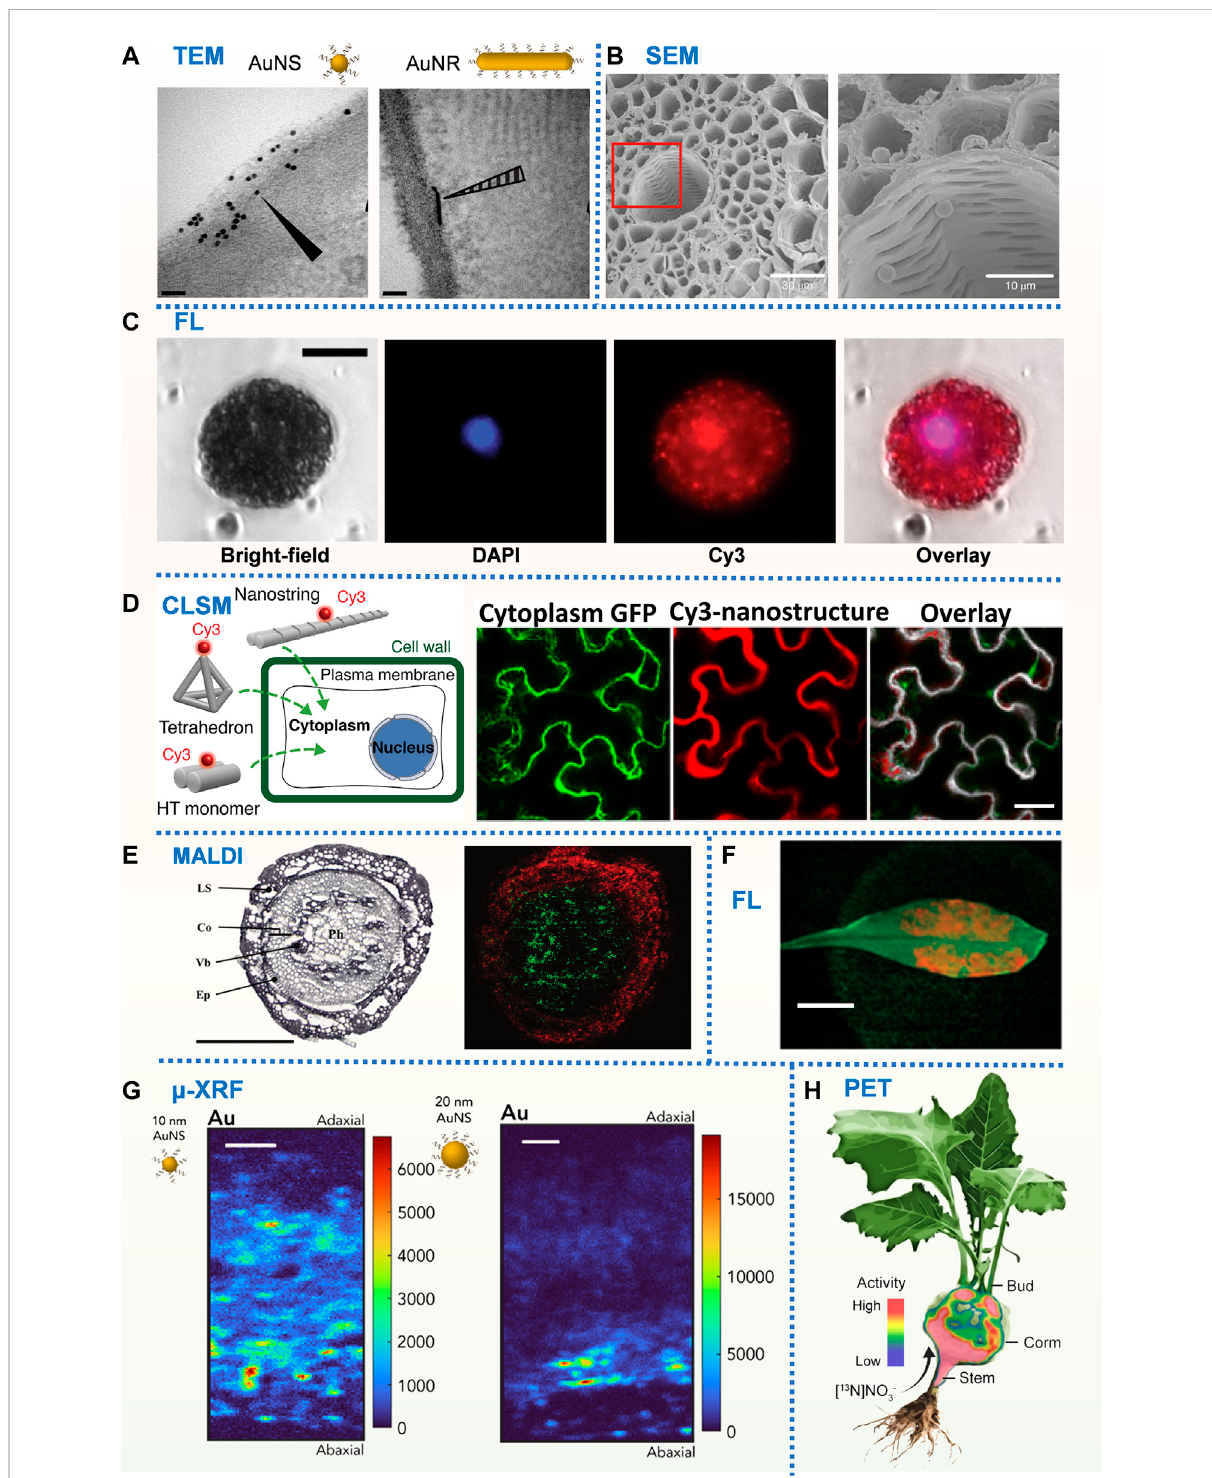
FIGURE 2 (A) TEM images of N. benthamiana plants 24 h post-in fi ltration with DNA-functionalized AuNS and AuNR. Scale bars, 50 nm (Zhang et al., 2022b). (B) SEM images of PS microbeads in the xylem vessels and cortical tissue. Scale bars, 30 µm (left) and10 µm (right) (Li et al., 2020). (C) Fluorescence microscopy imagesof Cy3-DNA-CNTs internalization into isolatedprotoplast cytosol and nucleus after incubation with DAPI-stained protoplasts. Scale bars, 20 µm (Demirer et al., 2019c). (D) DNA nanostructure internalization into and colocalization with mGFP5 Nb cytoplasm